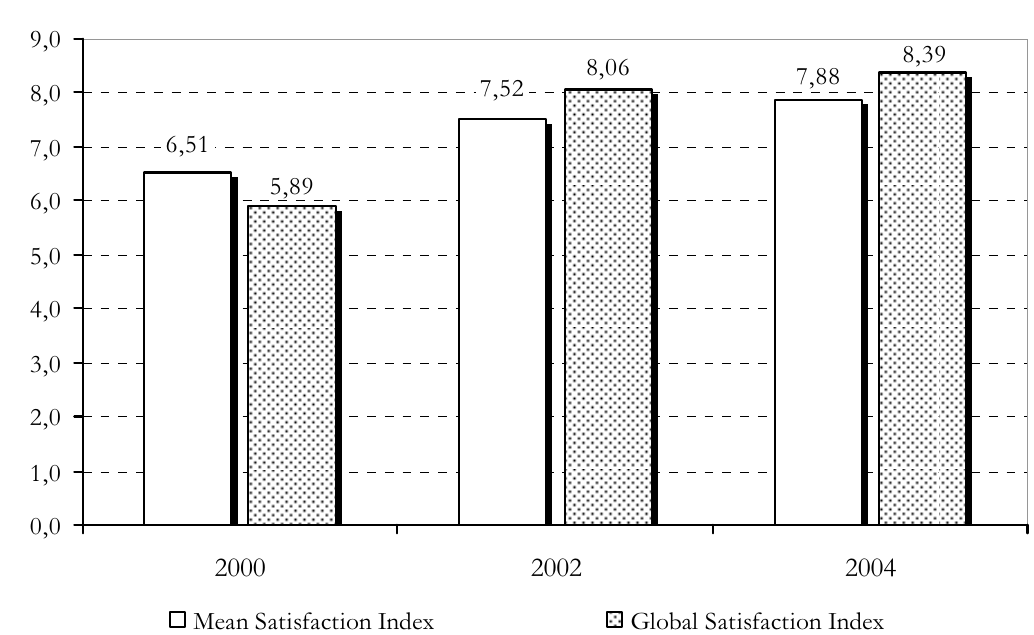
Figure 2 – The Mean Satisfaction Index and the Global Satisfaction Index (2000-2004).